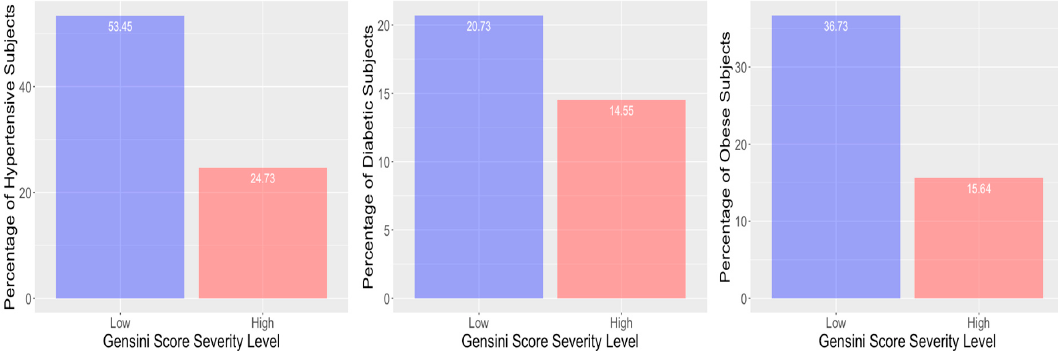
Figure 1. Percentages of subjects with hypertension, diabetes, and obesity in Gensini score low and high groups. Subjects presented at the cardiac catherization clinic were observed to have high prevalence of hypertension (78.18%, with 53.45% in low and 24.73% in high Gensini score severity level), diabetes (35.28 with 20.73% in low and 14.55% in high Gensini score severity level) and obesity (52.37%, with 36.73% in low and 15.64% in high Gensini score severity level).